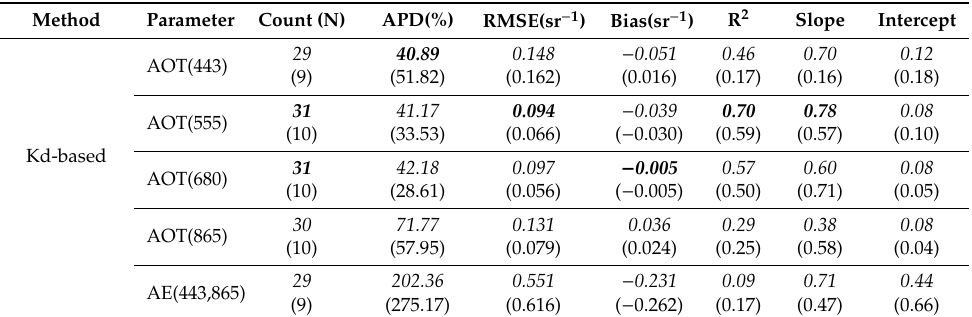
Table 8. Validation statistics for the Kd-based method of GOCI-derived AOT(443), AOT(555), AOT(680), AOT(865), and AE(443,865) at 02:16, 03:16, and 04:16 UTC: APD (%), RMSE (sr − 1 ), Bias (sr − 1 ), R 2 (dimensionless), Slope (dimensionless), Intercept (dimensionless). The presentation style is the same as described in Table 6.